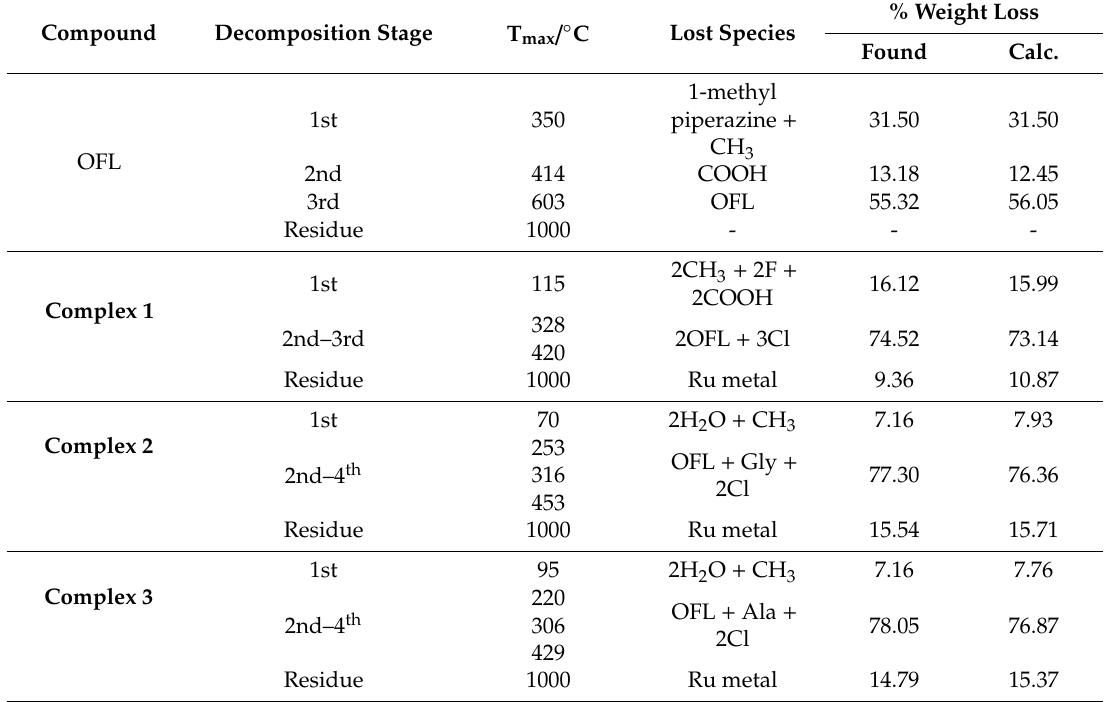
Table 5. The maximum temperatures and corresponding weight losses for the decomposition steps of free OFL and the synthesized